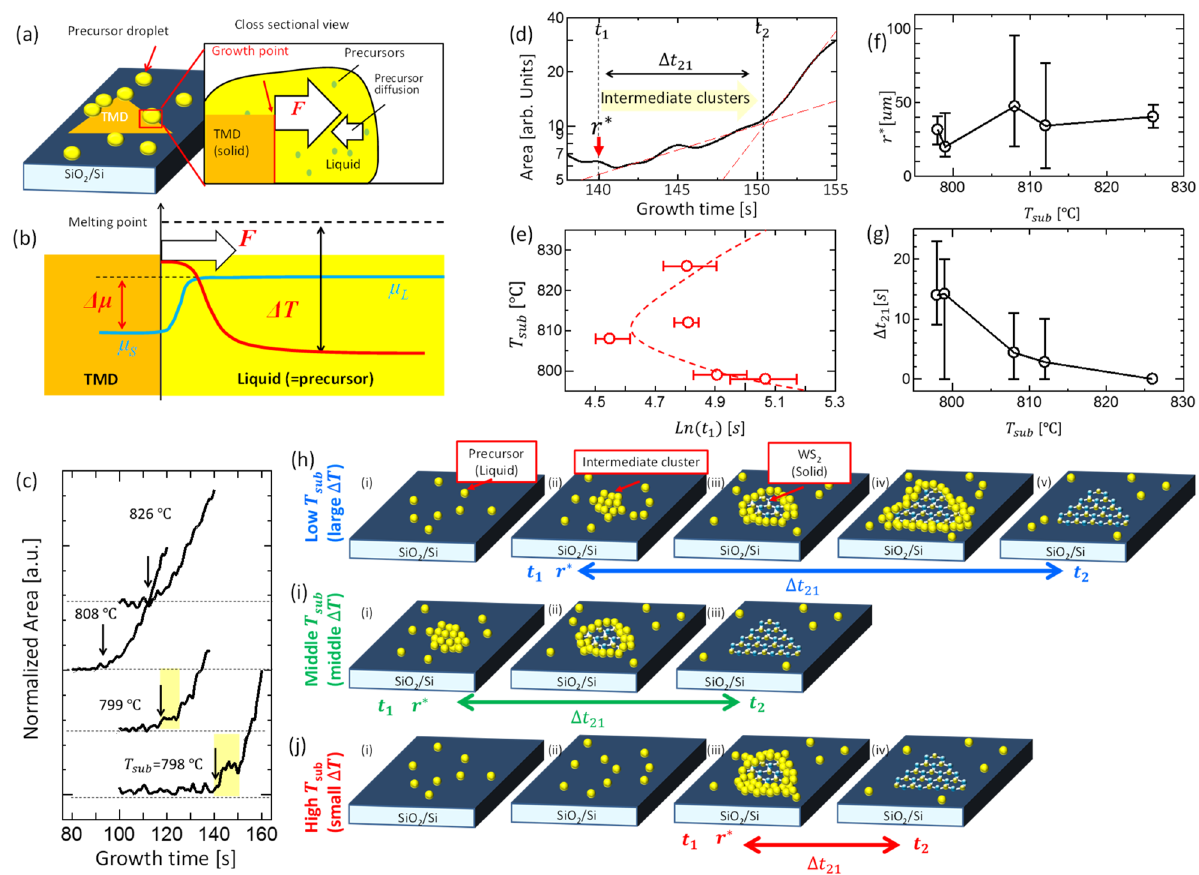
Figure 3. Thermodynamic approach for WS 2 nucleation. ( a , b ) Schematic of ( a ) WS 2 growth through the coagulation reaction and ( b ) enlarged interface between TMD and liquid precursor. ( c ) Time evolution of monolayer area of WS 2 grown under the different T sub . Arrow shows the t 1 for each growth. ( d ) Redefinition of parameters within the curve of area versus growth time at initial growth stage. ( e ) Plot of T sub line is guid for eye. ( f , g ) Plot of ( g ) r* and ( h ) (cid:31) t 21 as a function of T sub . ( h – j ) Schematic illustration of two-step nucleation of WS 2 under the different T sub ( i : Low T sub , j : Middle T sub , k : high T sub